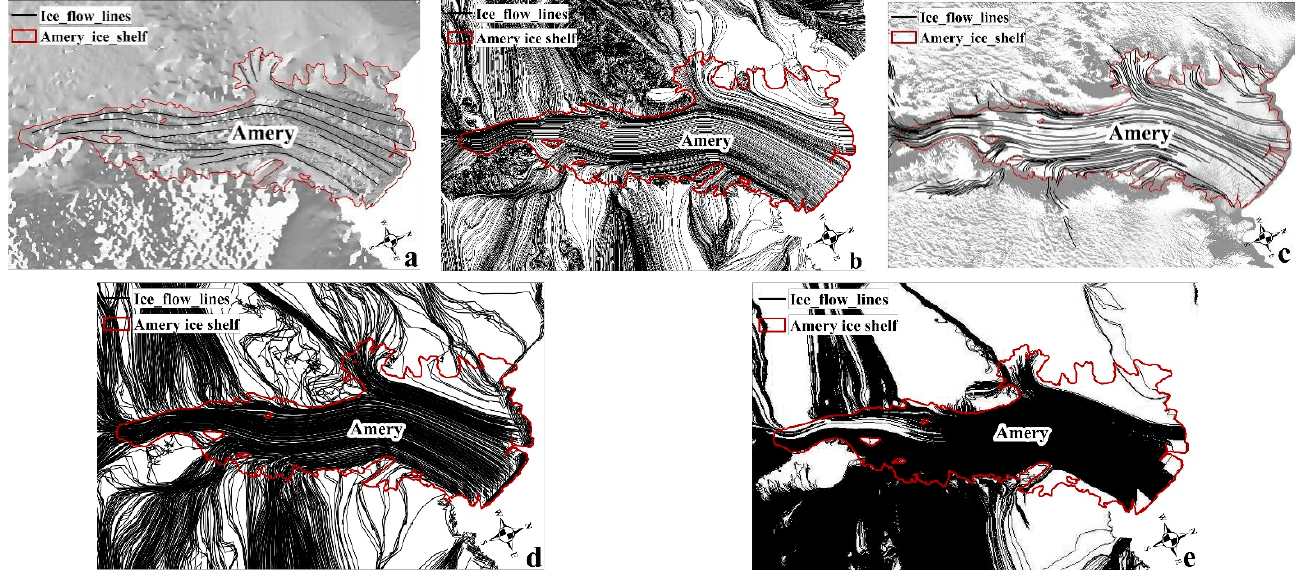
Figure 10. Comparisons of ice flow lines extraction on Amery ice shelf among the proposed method, other Antarctic data sets and Matlab and Python streamline function. The aspect map and MOA 2009 are used as background in subfigures ( a ) and ( c ), respectively. ( a ) Ice flow lines from Bedmap2 surface elevation. ( b ) Ice flow lines by the proposed method. ( c ) Ice flow lines from MOA2009. ( d ) Matlab Streamline extraction of ice flow lines. ( e ) Matlab Streamline extraction of ice flow lines